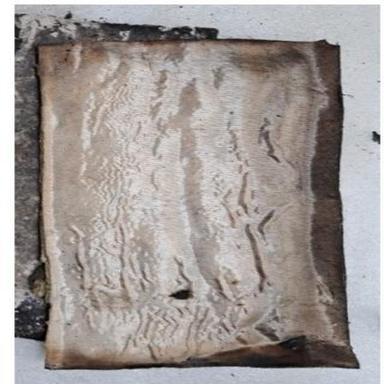
CSR thermal barrier material used inside the battery pack.